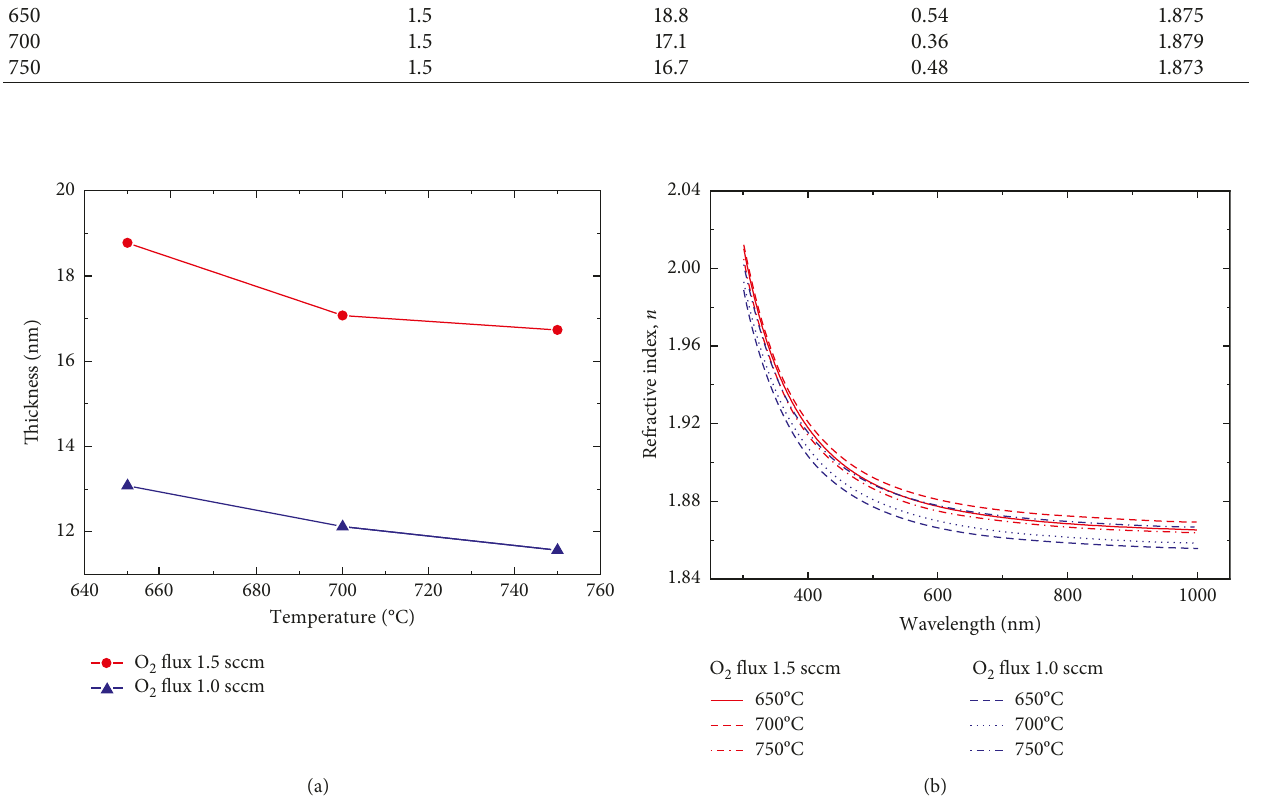
Figure 2: (a) Film thickness dependence on the substrate temperature at fluxes of 1.5 and 1.0sccm; (b) dispersion curves of the refractive index.